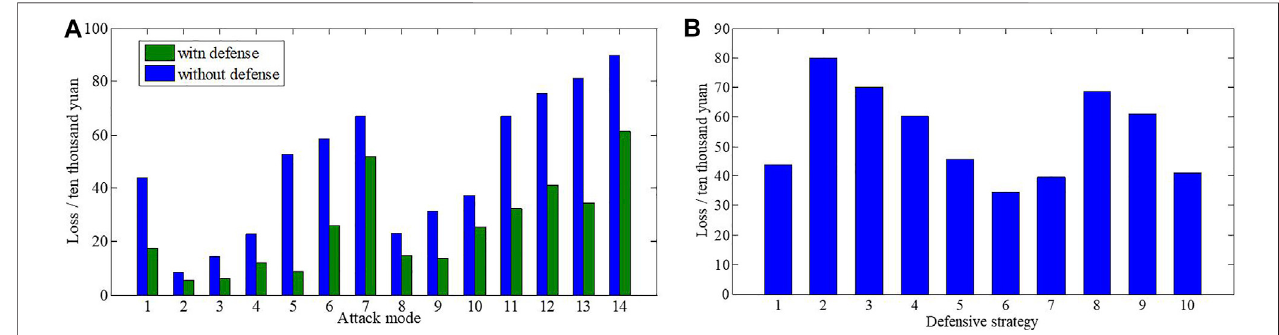
attacks are obtained as shown in Table 6 . The intersection of the offensive strategy and the defense strategy (green block) in Table 6 is the Nash equilibrium point under various attack modes.